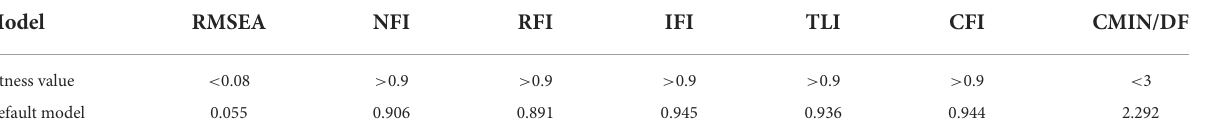
TABLE 3 Evaluation on goodness of model fitting ( N =